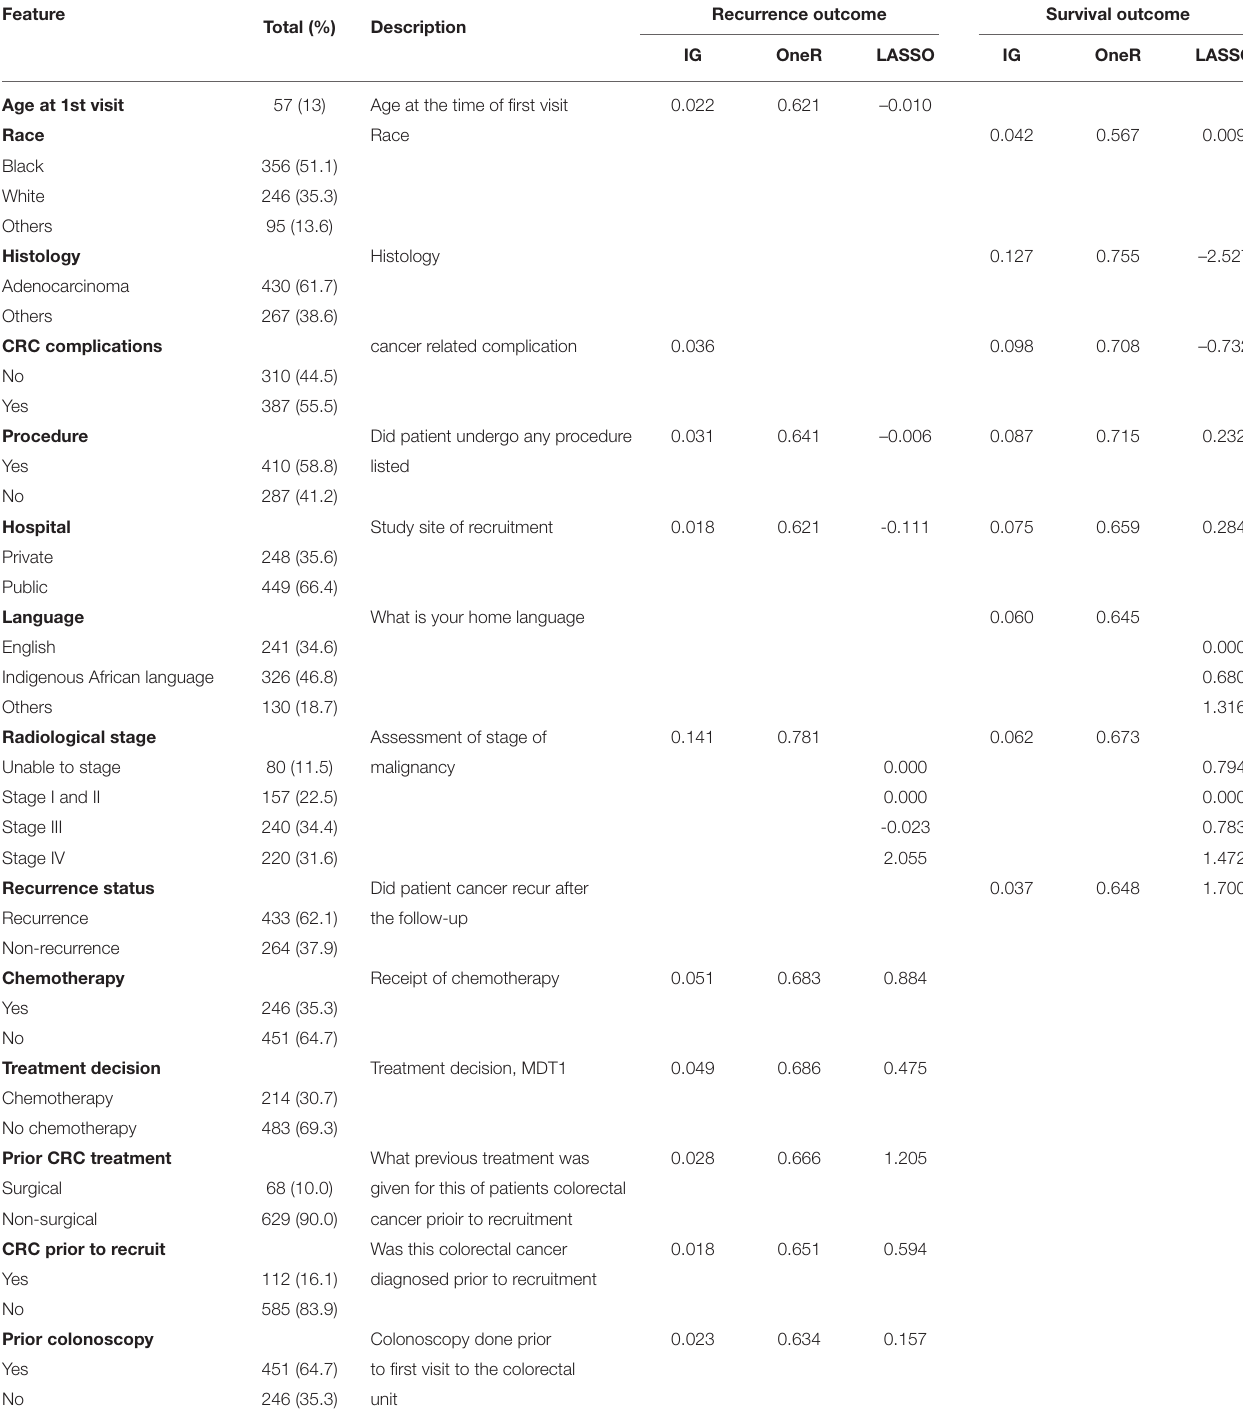
TABLE 1 | Characteristics of the WDGMC population based on the selected features from information gain, OneR, and LASSO.